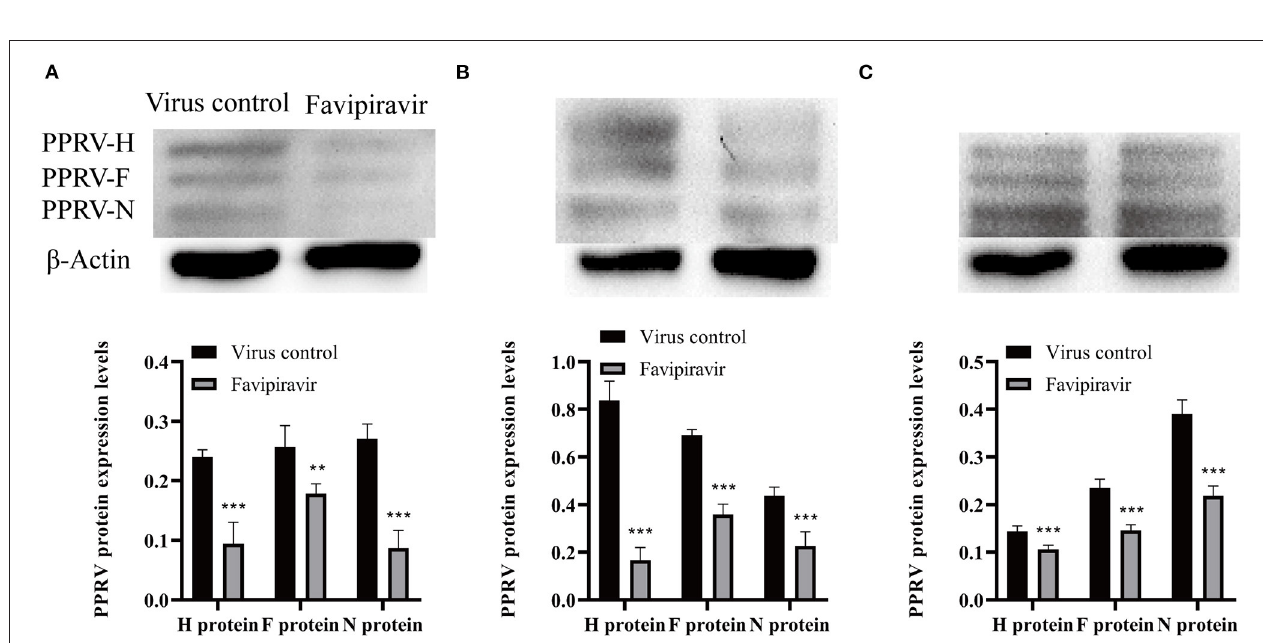
FIGURE 3 | The effect of favipiravir on peste des petits ruminants virus (PPRV) attachment to host cells. Vero cells were pre-incubated with favipiravir at 50 µ g/ml or an equal volume of medium at 37 ◦ C for 1h and then infected with PPRV at 4 ◦ C for 2h. The cells were washed five times with cold phosphate-buffered saline (PBS) and collected for qPCR and immunofluorescence assay (IFA) detection (** p < 0.01, *** p < 0.001 vs . the virus-only control). (A) The mRNA expression of the H and N genes. (B) PPRV distribution in the cytoplasm was detected by indirect IFA. Scale bars = 100 µ m.